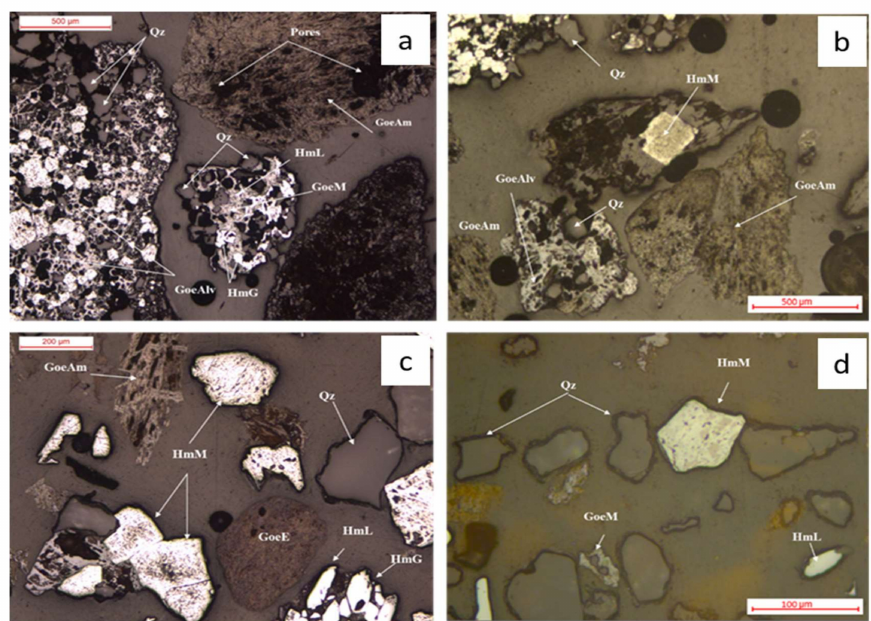
Figure 5. Reflected light optical microscopy images: ( a ) particle size fraction + 1000 µ m (parallel polarizers) showing the goethite: amphibolitic (GoeAm) porous, alveolar (GoeAlv) and massive (GoeM) with granular hematite (HmG) and lamellar (HmL, upper left particle); ( b ) particle size − 1000 + 500 µ m (parallel polarizers) containing martitic hematite (HmM, central grain), quartz (Qz), alveolar goethite (GoeAlv) and amphibolitic (GoeAm, lower right particle); ( c ) particle size fraction − 500 + 150 µ m (parallel polarizers) showing the presence of particles free of quartz (Qz), martitic hematite (HmM), amphibolitic goethite (GoeAm) and earthy goethite (GoeE), in addition to a particle containing lamellar (HmL) and granular (HmG) hematite grains, and ( d ) particle size − 150 + 45 µ m (parallel polarizers) highlighting the presence of free quartz (Qz), martitic hematite (Hm), lamellar hematite (HmL) and massive goethite (GoeM).